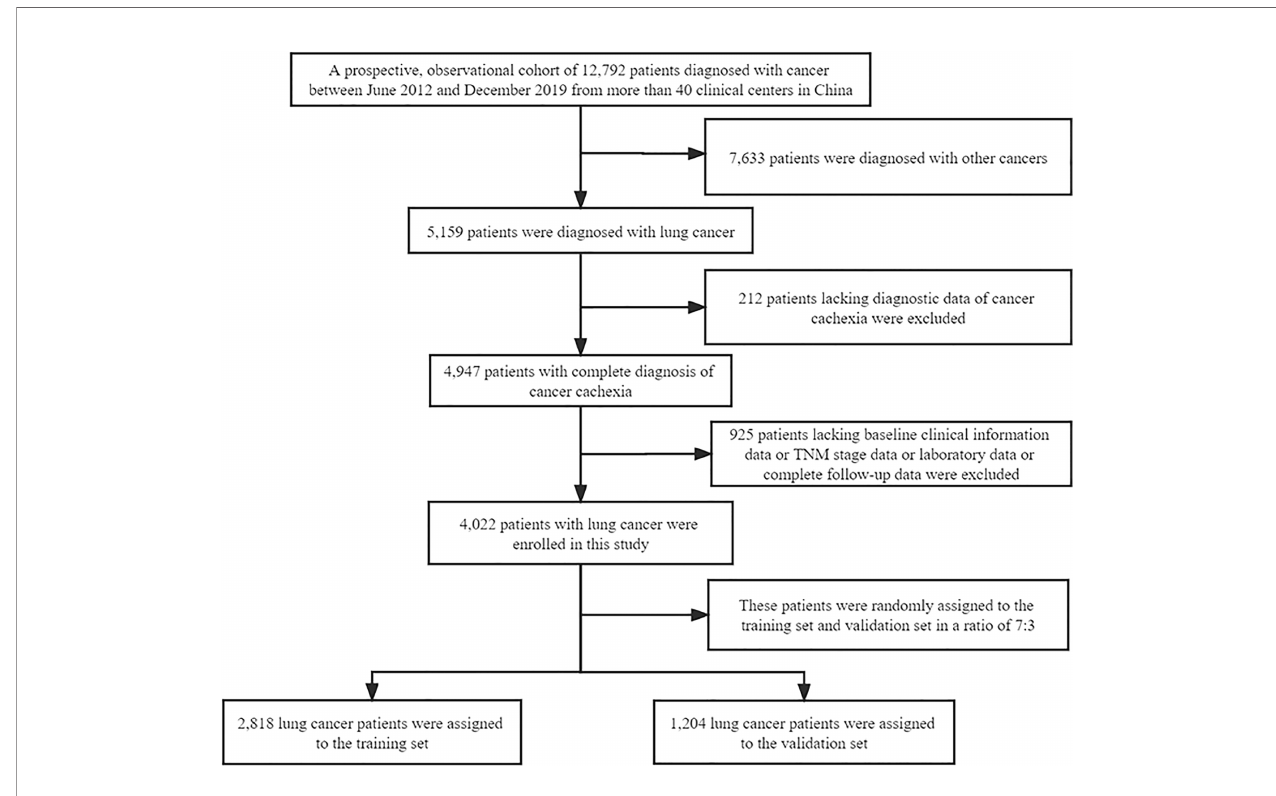
FIGURE 1 | Flow chart of study